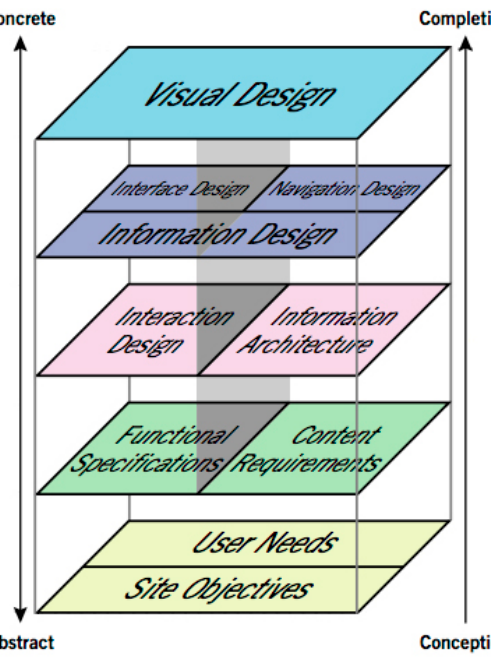
Figure 1. The elements of user experience for conceptual design (Adapted from [12]).